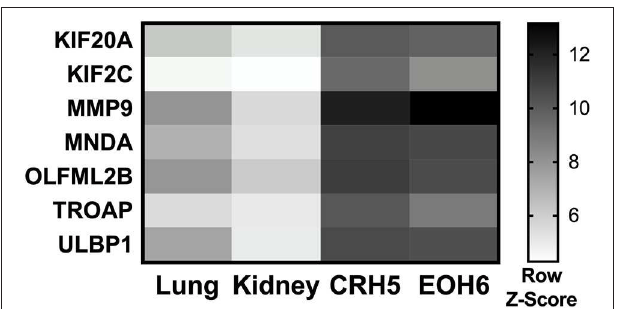
FIGURE 1 | p-Tvax antigens are overexpressed in MM tumors. Transcriptome analysis using mRNA-microarrays was performed on two MM mouse tumors (grown from injected CRH5 or EOH6 cells) and two normal tissues (kidney and lung). mRNA levels are indicated by Row Z-Score colors in a heat map. Antigens with the higher mRNA level for both tumors, compared with both normal tissues, were selected for inclusion in the p-Tvax vaccine. Differences in mRNA levels between each MM tumor and each normal tissue were statistically significant for all antigens ( p < 0.001).